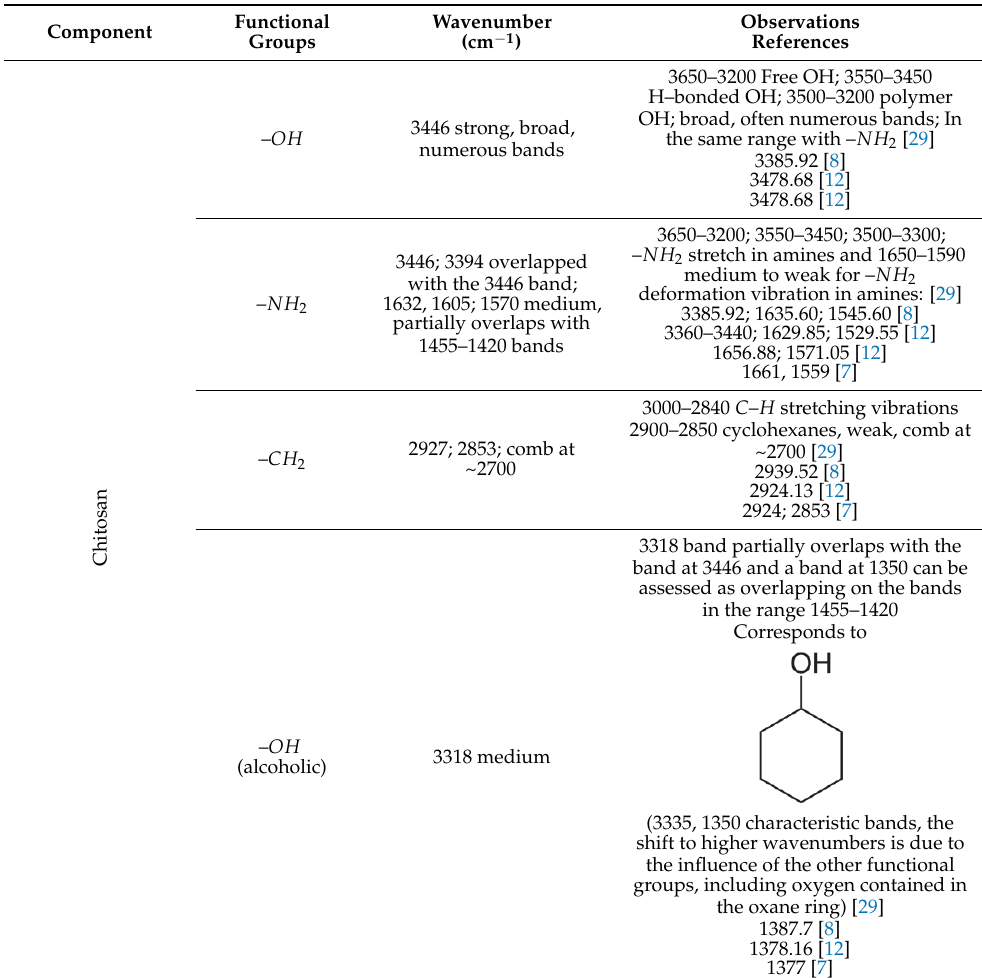
Table 2. The FTIR spectrum bands and interpretation for the thin film obtained by LICD from raw oyster